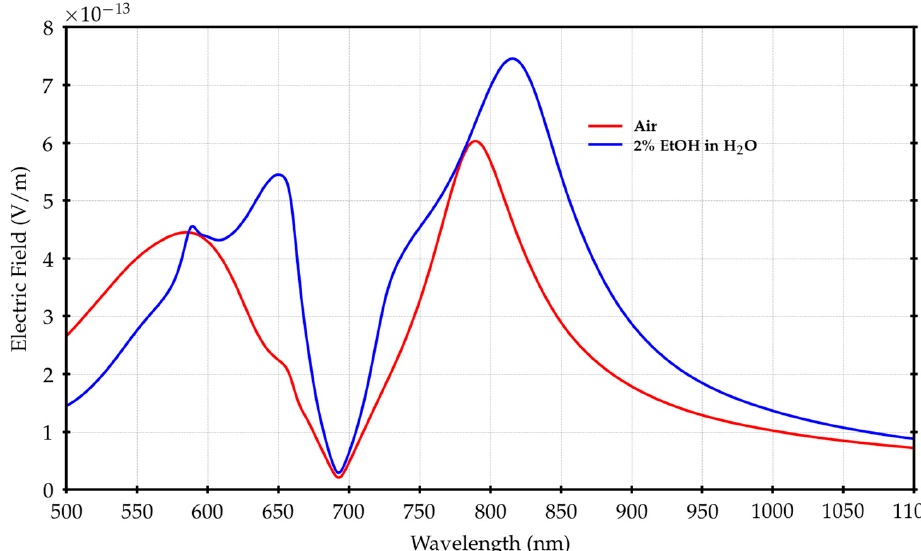
Figure 5. Spectral profiles of the electric field magnitude calculated by integration in the x–y horizontal plane placed at z = 130 nm for air and the 2% EtOH solution as surrounding mediums. Thanks to this shift, it is possible to see the peak at 680 nm within our measurement region.